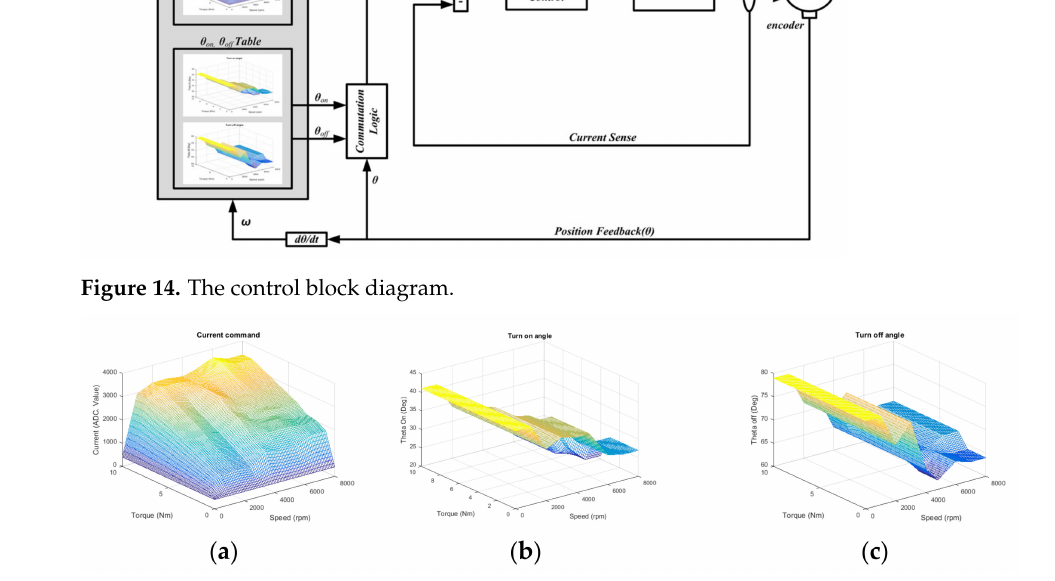
Figure 15. Optimal value of ( a ) current command; ( b ) turn-on angle; and ( c ) turn-off angle at each torque command and motor speed level for optimal efficiency